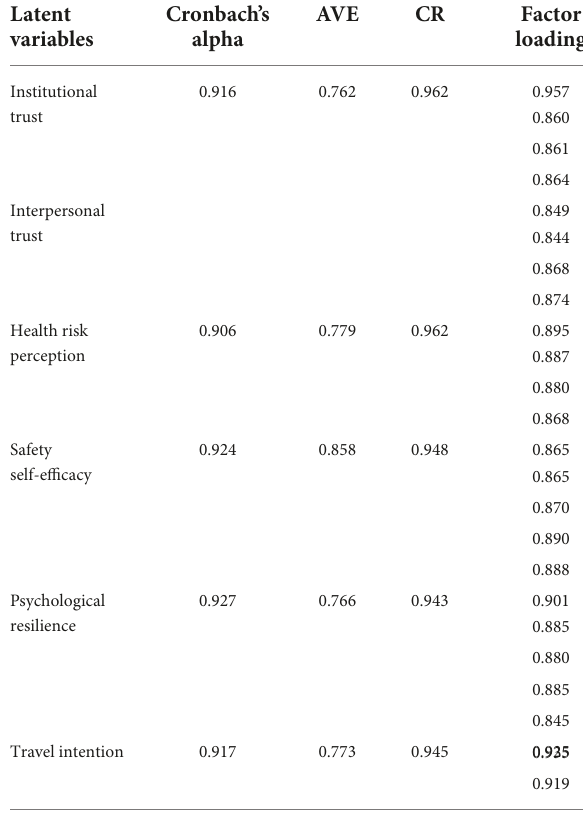
TABLE 1 Index system of PLS path analysis